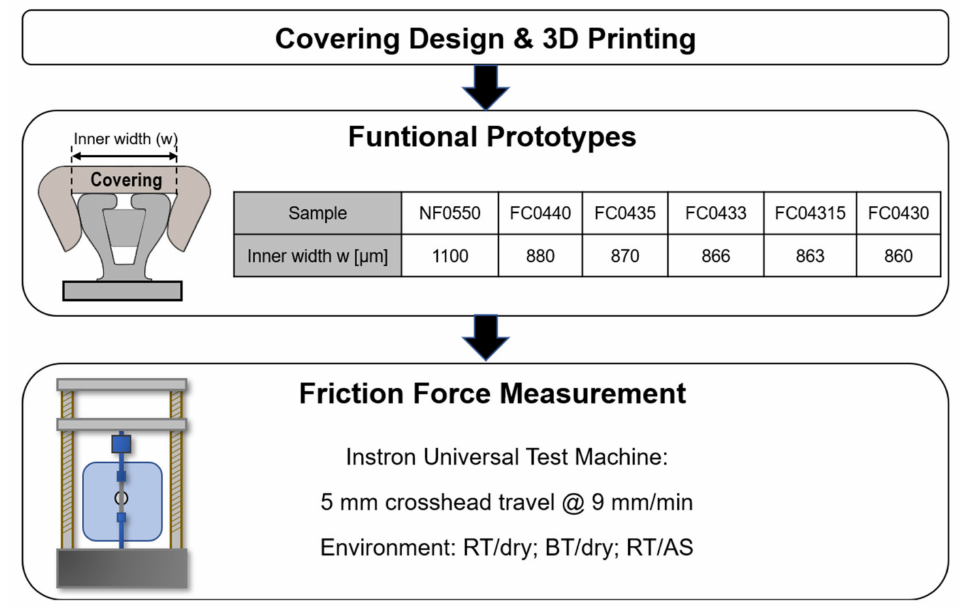
Figure 1. The applied workflow for the present in-vitro study consists of the design phase, followed by 3D printing of functional samples with the main parameter “inner width” shown in the table. The friction force measurements were carried out in a universal testing machine under the environmental conditions as shown above (RT: room temperature; BT: body temperature, AS: artificial